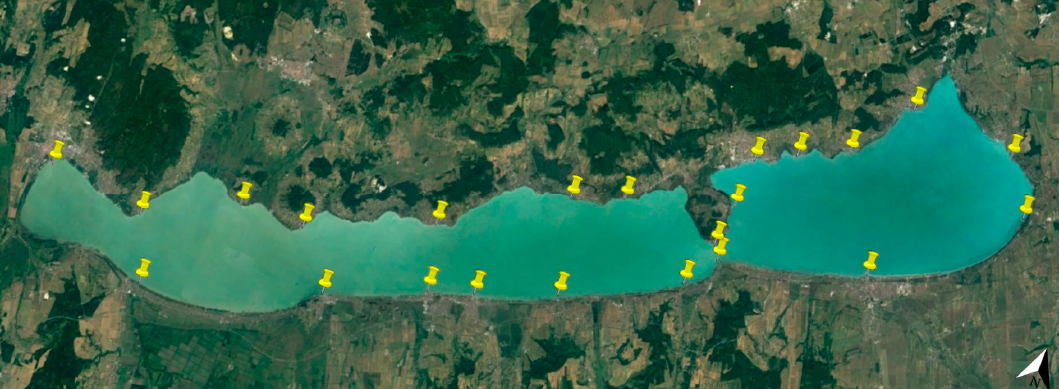
Figure 2. The number of sailing marinas per town/village at Lake Balaton, based on [55]. Figure 3. The passenger ports of Lake Balaton, based on [55]. Figure 3. The passenger ports of Lake Balaton, based on